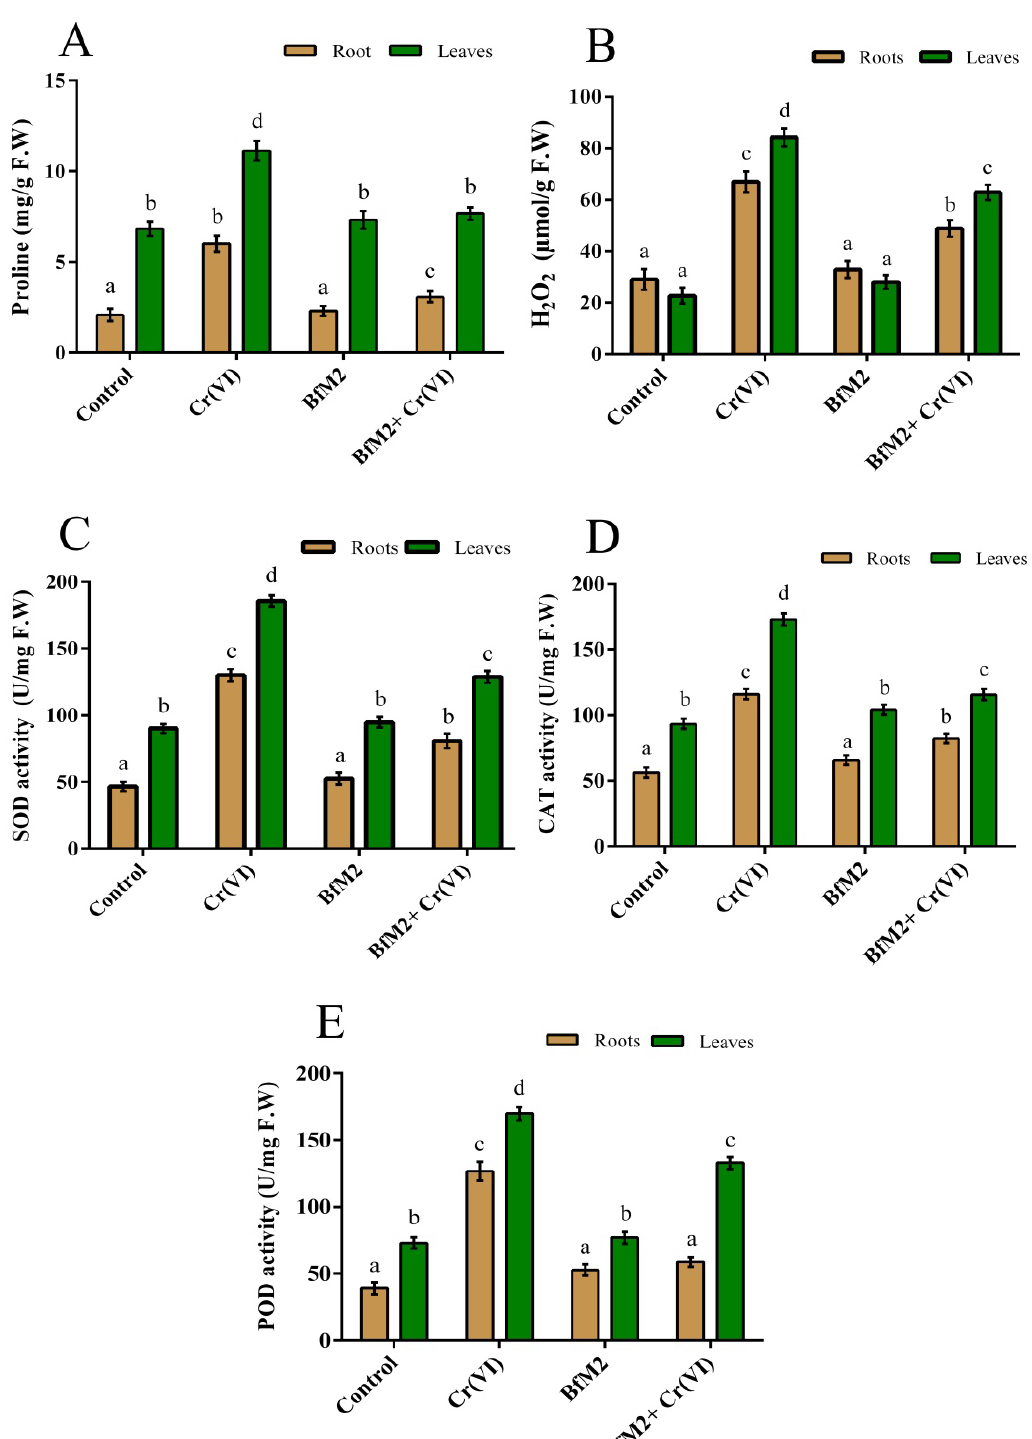
Figure 5. Effect of Cr(VI) and the rhizobacterial strain M2 on ( A ) proline and ( B ) H 2 O 2 contents of V. radiata ; ( C ) SOD; ( D ) CAT; and ( E ) POD activities of V. radiata The values are presented as the mean ± S.E (standard error) (n = 3). Different lowercase letters above bar charts indicate significant difference ( p < 0.05) between members in the group.